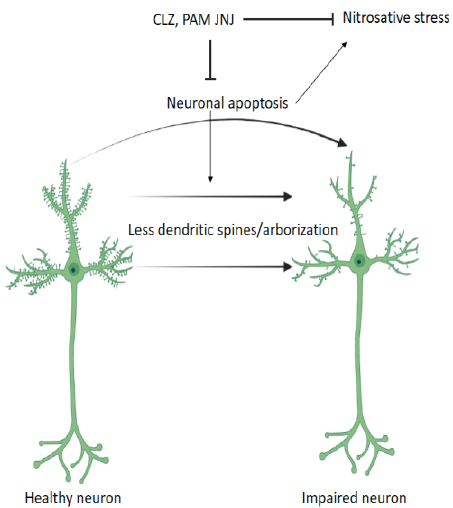
Figure 3. Antipsychotic compounds CLZ and mGlu2r PAM JNJ, among others, may halt both neuronal local apoptosis related to dendritic spines and arborization and subsequent nitrosative stress. CLZ, clozapine; PAM, positive allosteric modulator, JNJ,